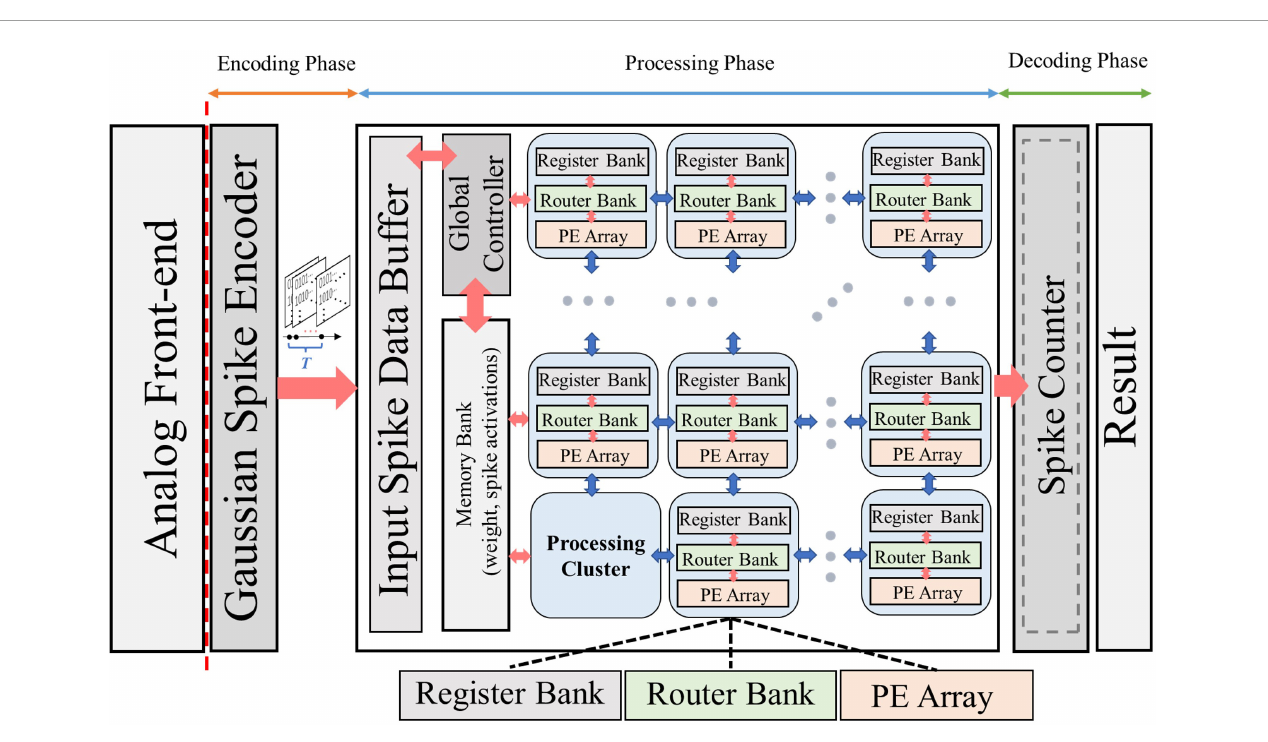
FIGURE6 Overall system architecture design of NeuroCARE, consisting of encoding phase, processing phase and decoding